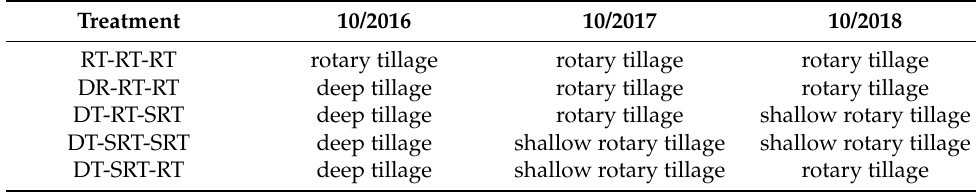
Table 4. The soil tillage practice before winter wheat seeding during 2016–2018.